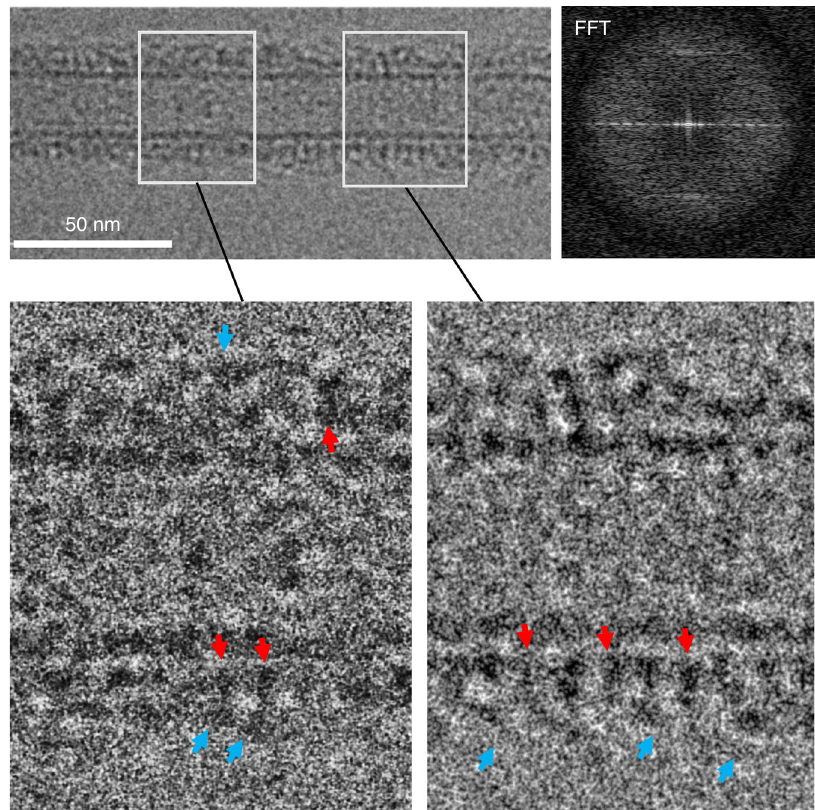
Fig. 5 Ca 2 + disrupts the Syt1 C2AB – SNARE organization on the lipid membrane. Cryo-EM micrograph of the Syt1 C2AB -SNARE decorated lipid tube in the presence of 1 mM Ca 2 + (top left) shows that proteins heavily decorate the LNT surface without forming any pronounced organized structures. Correspondingly, Fourier transform of the vertically oriented tube (top right) shows smeared diffraction peaks. Magni fi cation of the decorated LNTs (bottom) shows regions of both densely (right) and sparsely (left) packed protein on the LNT surface (red arrows), with scattered elongated densities (cyan arrows) extending out from the lipid surface. The protein density on the membrane surface (red arrows) is best approximated by the Syt1 C2 domain, with the SNAREpins corresponding to the auxiliary density (cyan arrow) on the top. It appears that the SNAREpins are displaced from the primary-binding site on the Syt1